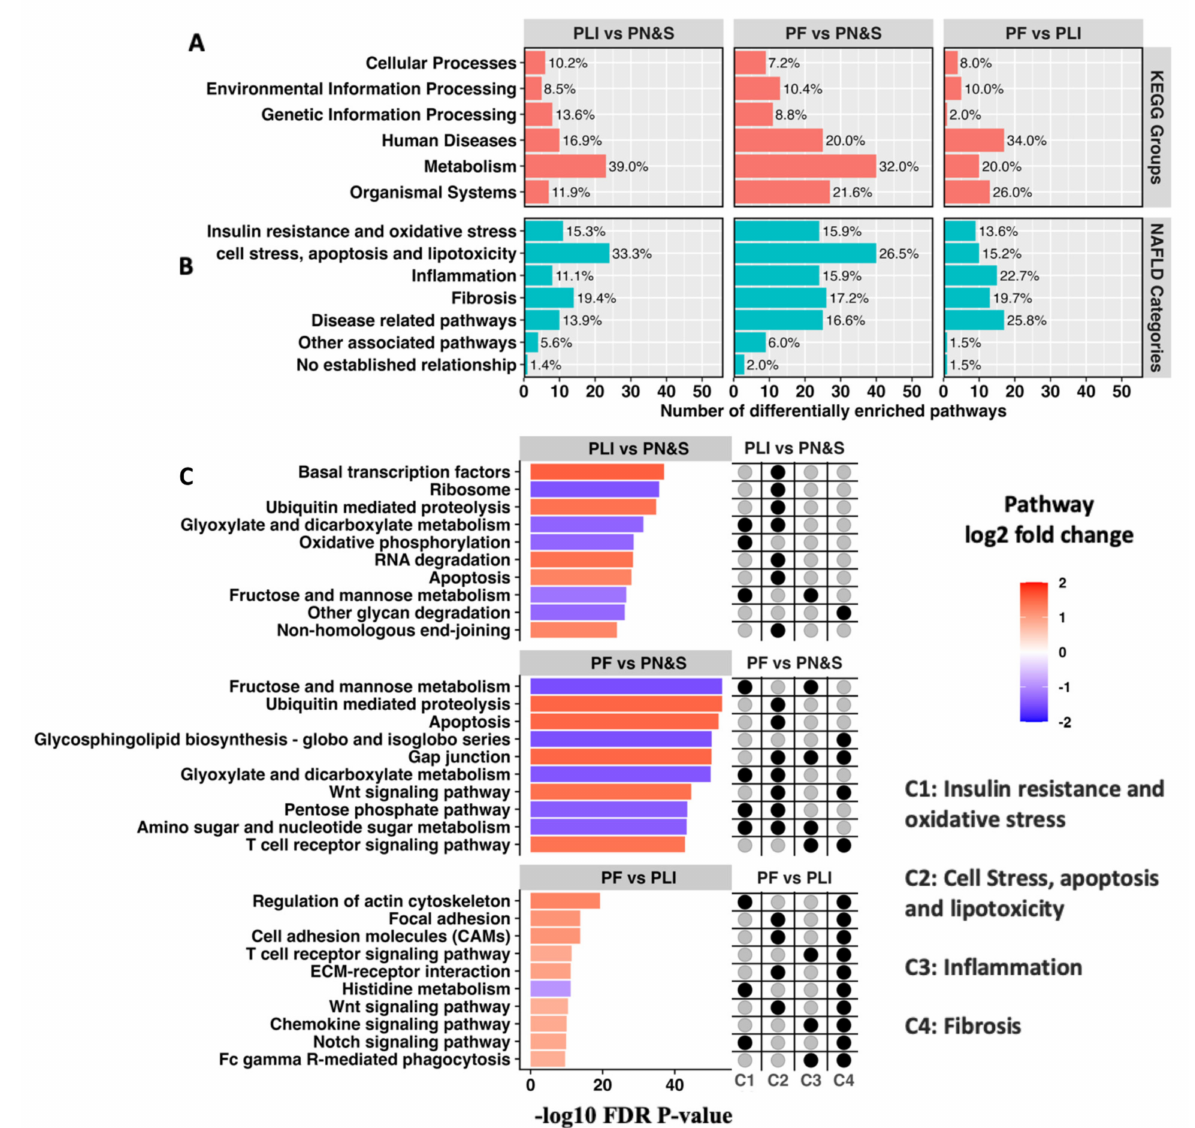
Figure 3. Distribution of differentially enriched pathways and their respective KEGG groups and NAFLD categories among the pairwise cluster comparisons defined in Figure 2. The number of differentially enriched pathways identified between the PLI vs. N&S, PF vs. N&S, and PF vs. PLI pairwise comparisons were 59, 125, and 50, respectively (adj. p -value < 0.001). Their distribution (and percent contribution) with respect to KEGG groups ( A ) and NAFLD categories ( B ) are detailed in Table S3 and Data file S1. The top ten differentially enriched pathways for each comparison (ranked by the FDR adjusted p -values through the linear modeling equivalent of a two-sample, moderated t -test) are shown along with their association (black circles) with NAFLD categories C1–4 (as indicated and defined in the Main Text) ( C ). The colors of the bars represent the directionality and relative enrichment of each pathway for each of the pairwise